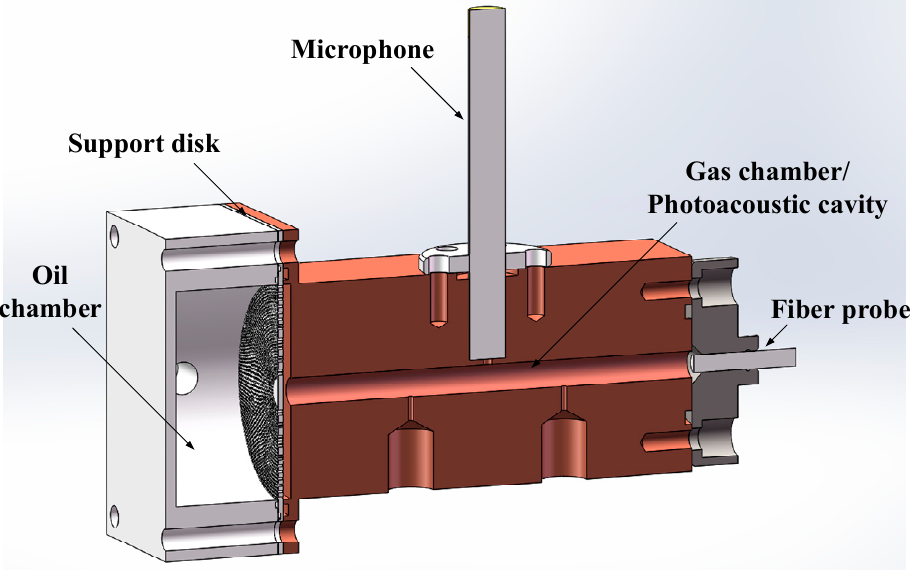
Figure 3. Structure of integration photoacoustic cell.